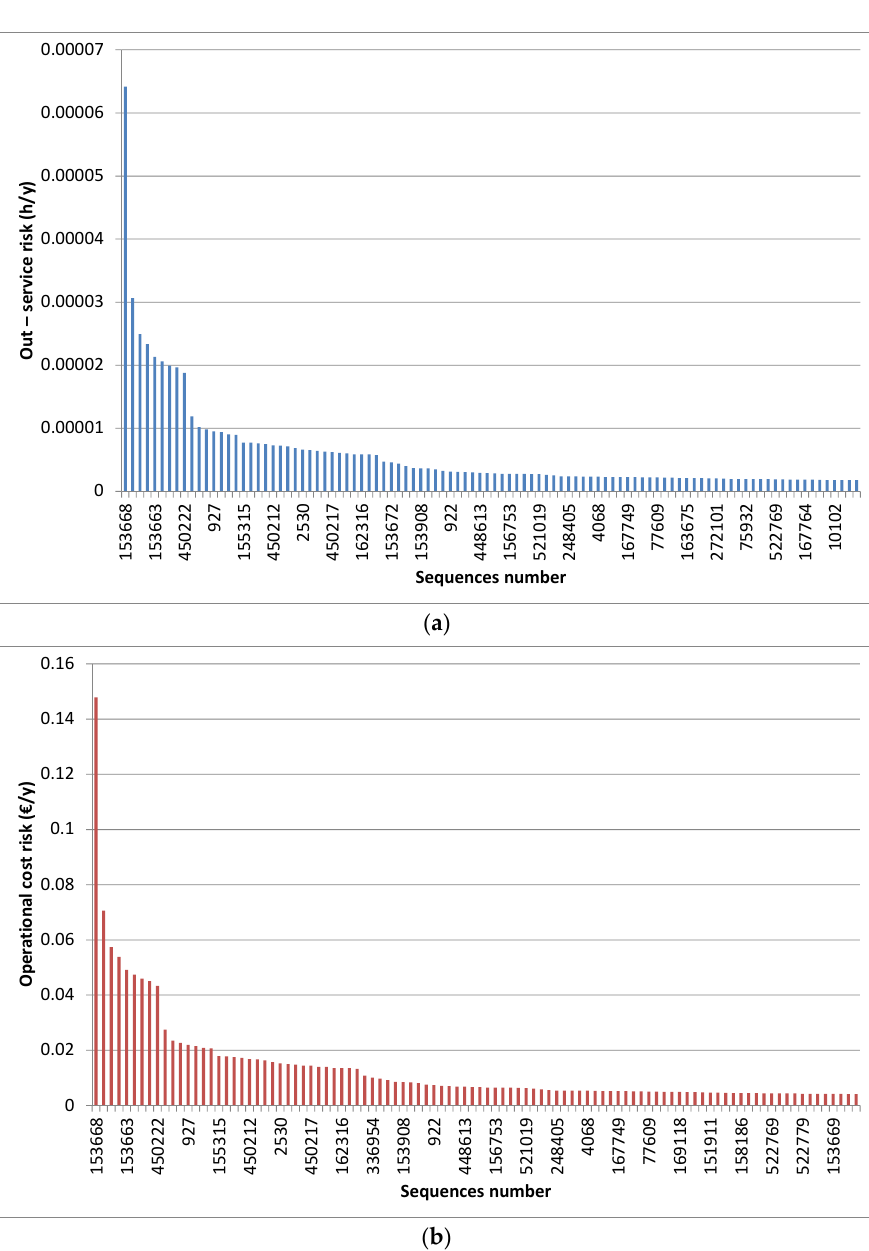
Figure 11. The risk of the sequences of events contain the catalyst sinterization for the fixed ‐ bed based plant.